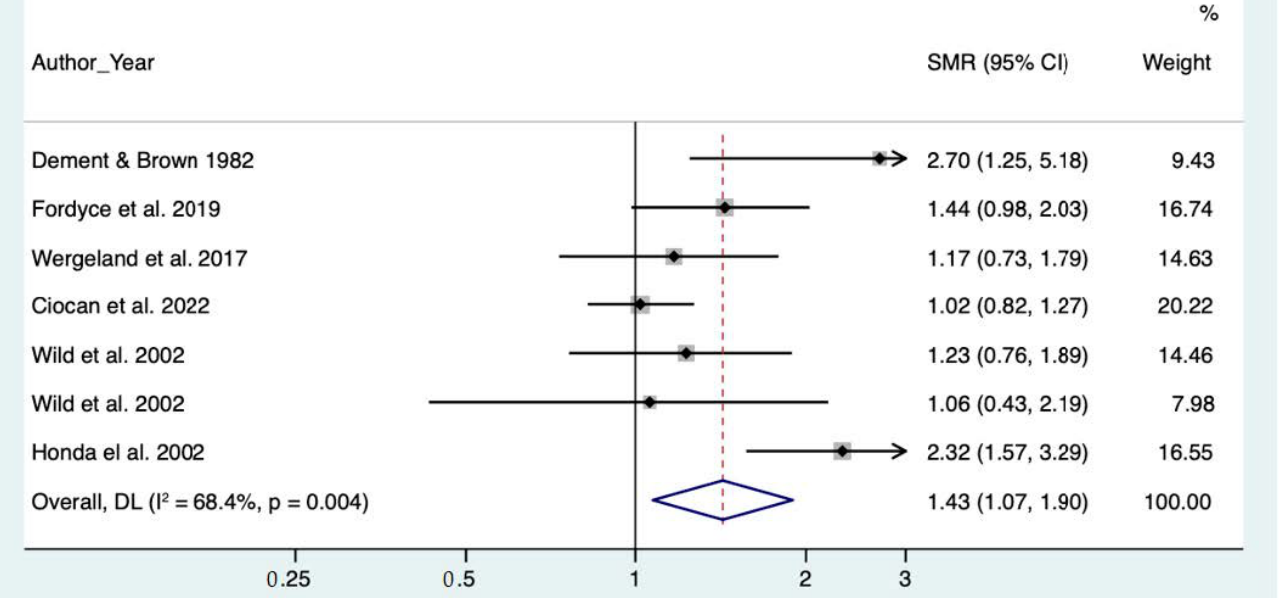
Figure 4. Meta analysis of lung cancer. [11–13,15,26,27]